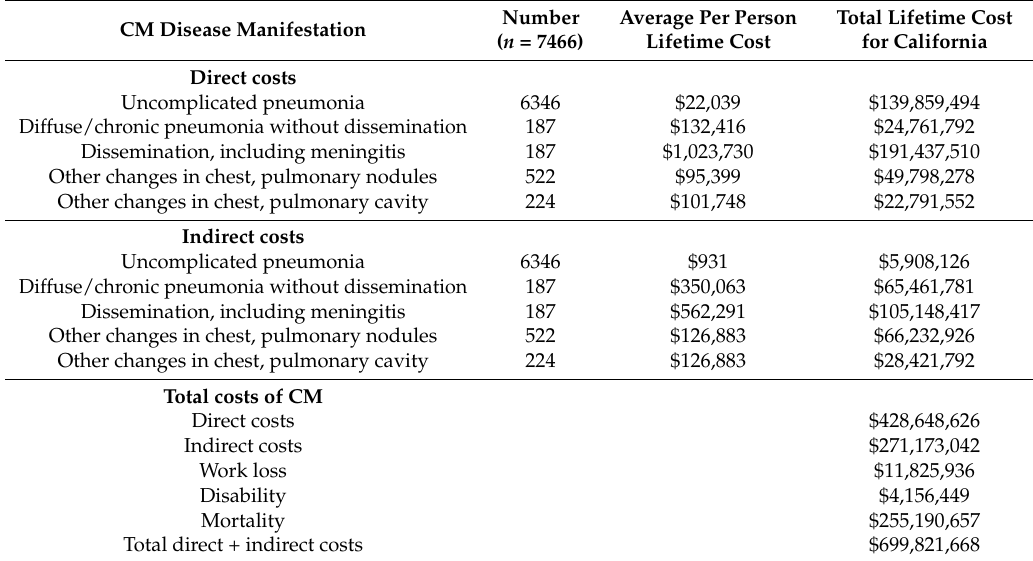
Table 2. Estimated total direct and indirect lifetime costs, stratified by types of costs and coccidioidomycosis (CM) disease manifestation, for incident CM cases in 2017 ( n = 7466) in